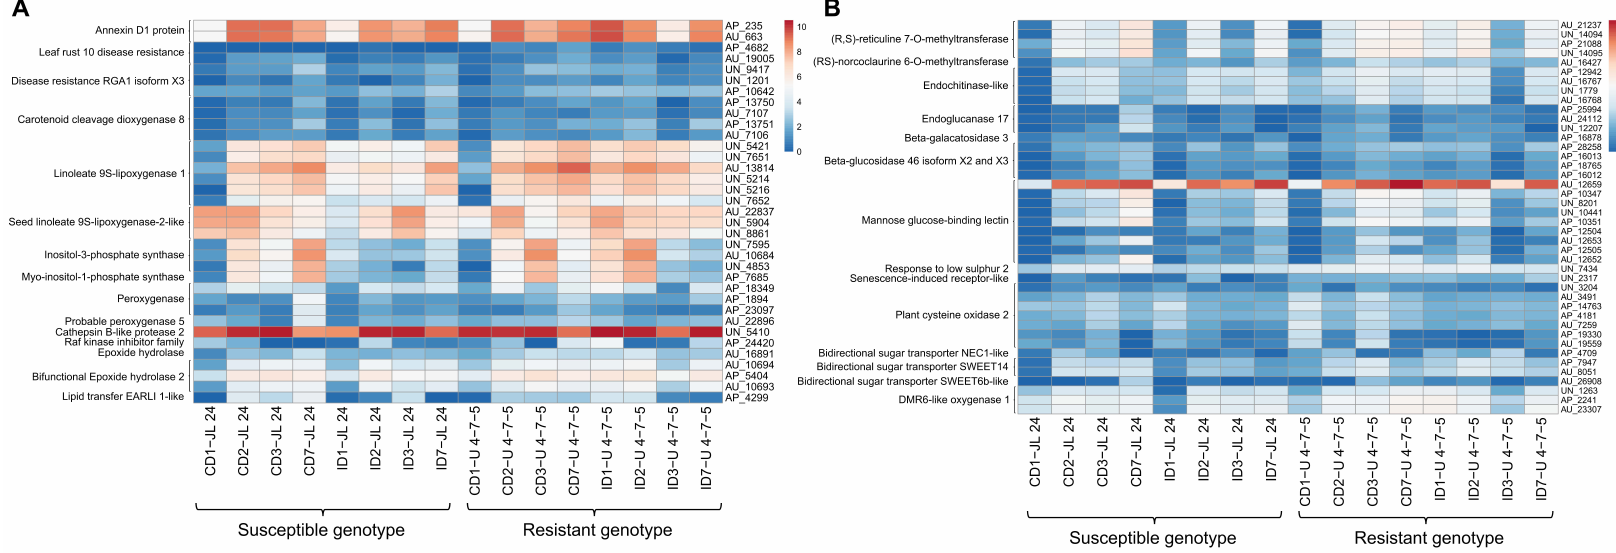
Figure 5. Heat maps of transcripts from disease-related pathways a ff ected in 16 groundnut genotypes during control and infected conditions in response to A. flavus infection. In both ( A , B ), red color depicts the upregulation and blue color depicts the downregulation in the gene expression pattern. Color codes corresponds to the FPKM value of the transcripts which are increasing from blue to red color. Genotypes (JL 24 and U 4-7-5) and treatment level (control and infected) are shown at the top of the